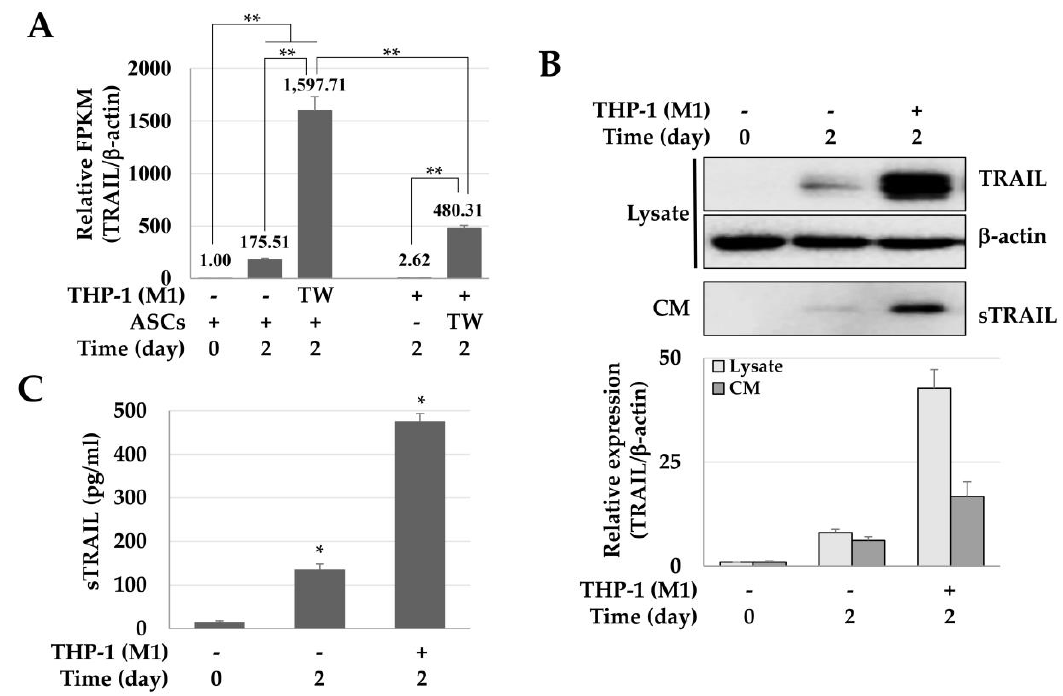
Figure 1. Enhanced expression of tumor necrosis factor (TNF)-related apoptosis-inducing ligand (TRAIL) in adipose tissue-derived stem cells (ASCs) co-cultured with M1 macrophages. ASCs were cultured at high-density or co-cultured with M1 macrophages (THP-1) for 2 days and harvested to analyze the TRAIL mRNA and protein, and conditioned media were stored after centrifugation to detect the secreted TRAIL (sTRAIL). ( A ) Relative expression of TRAIL in ASCs cultured at a high density or with M1 macrophages. The relative expression of TRAIL was analyzed by a next-generation sequencing assay, and the relative values are presented in Fragments Per Kilobase Million (FPKM). ** p < 0.01. ( B ) Expression of TRAIL in cell lysates and conditioned medium (CM). TRAIL was detected in cell lysates and CM using immunoblotting. β-actin was used for normalization. ( C ) Expression of sTRAIL. * p < 0.05.